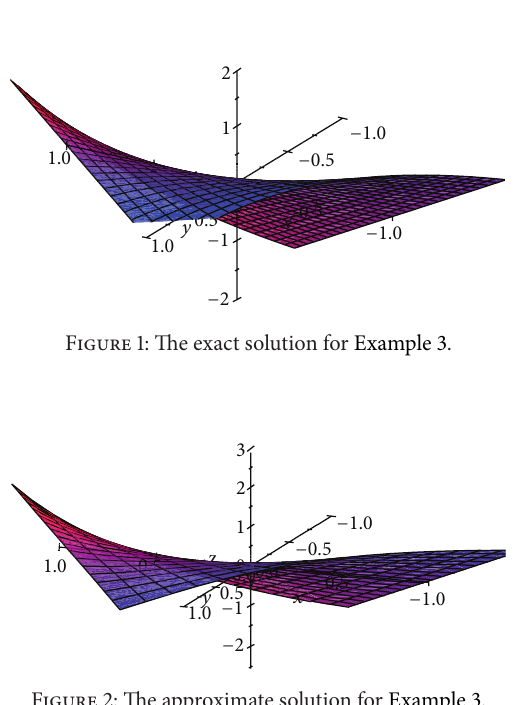
Figure 2: The approximate solution for Example